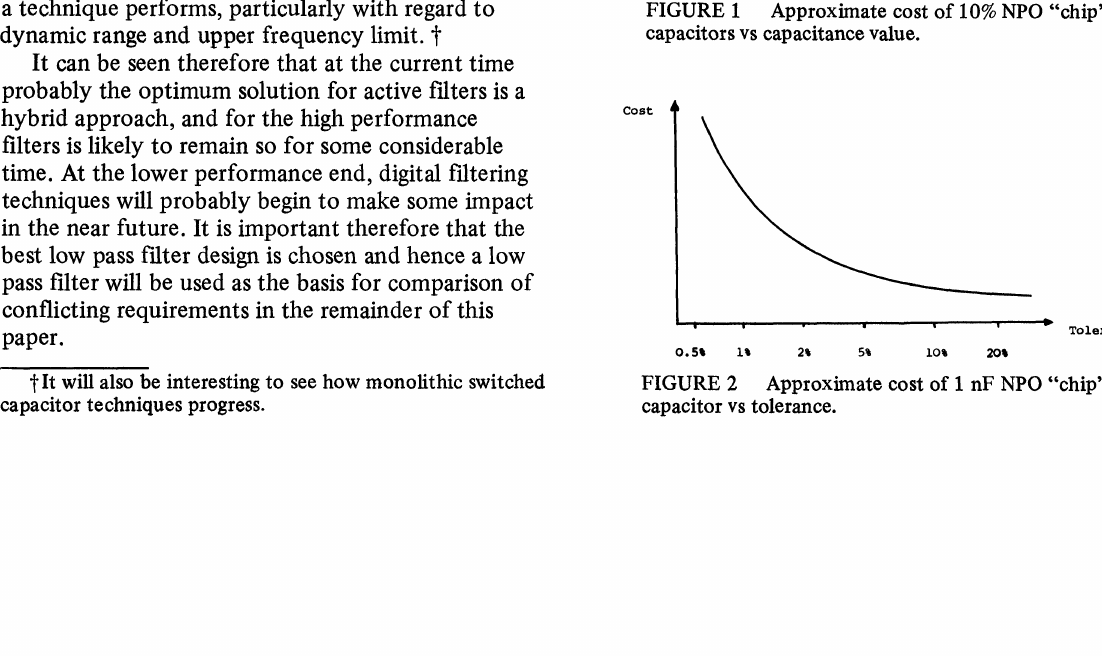
FIGURE 1 Approximate cost of 10% NPO "chip" capacitors vs capacitance value.